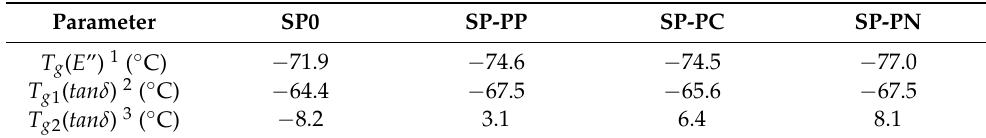
Table 6. Glass transition temperatures of the propellants based on loss modulus and loss factor ( f = 1